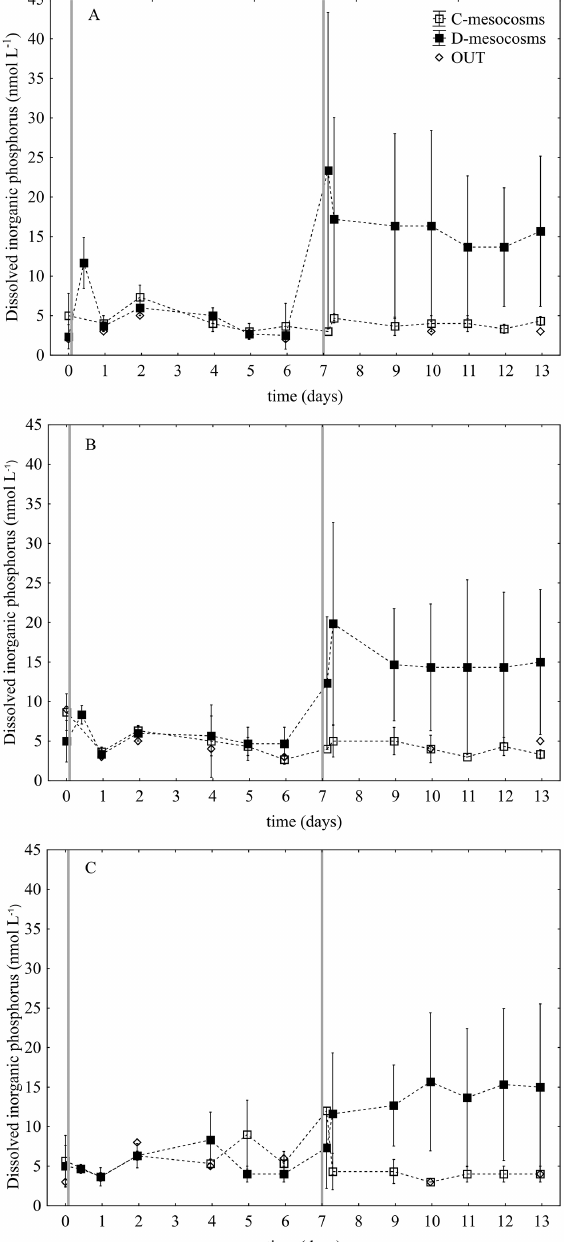
Figure 2. Bacterial abundance (cellmL − 1 , mean ± standard devi- ation of three replicate mesocosms) in D- and C-mesocosms and OUT samples at surface (a) , 5m (b) and 10m (c) depth during the DUNE-R experiment. Grey vertical bars represent the dust seed-